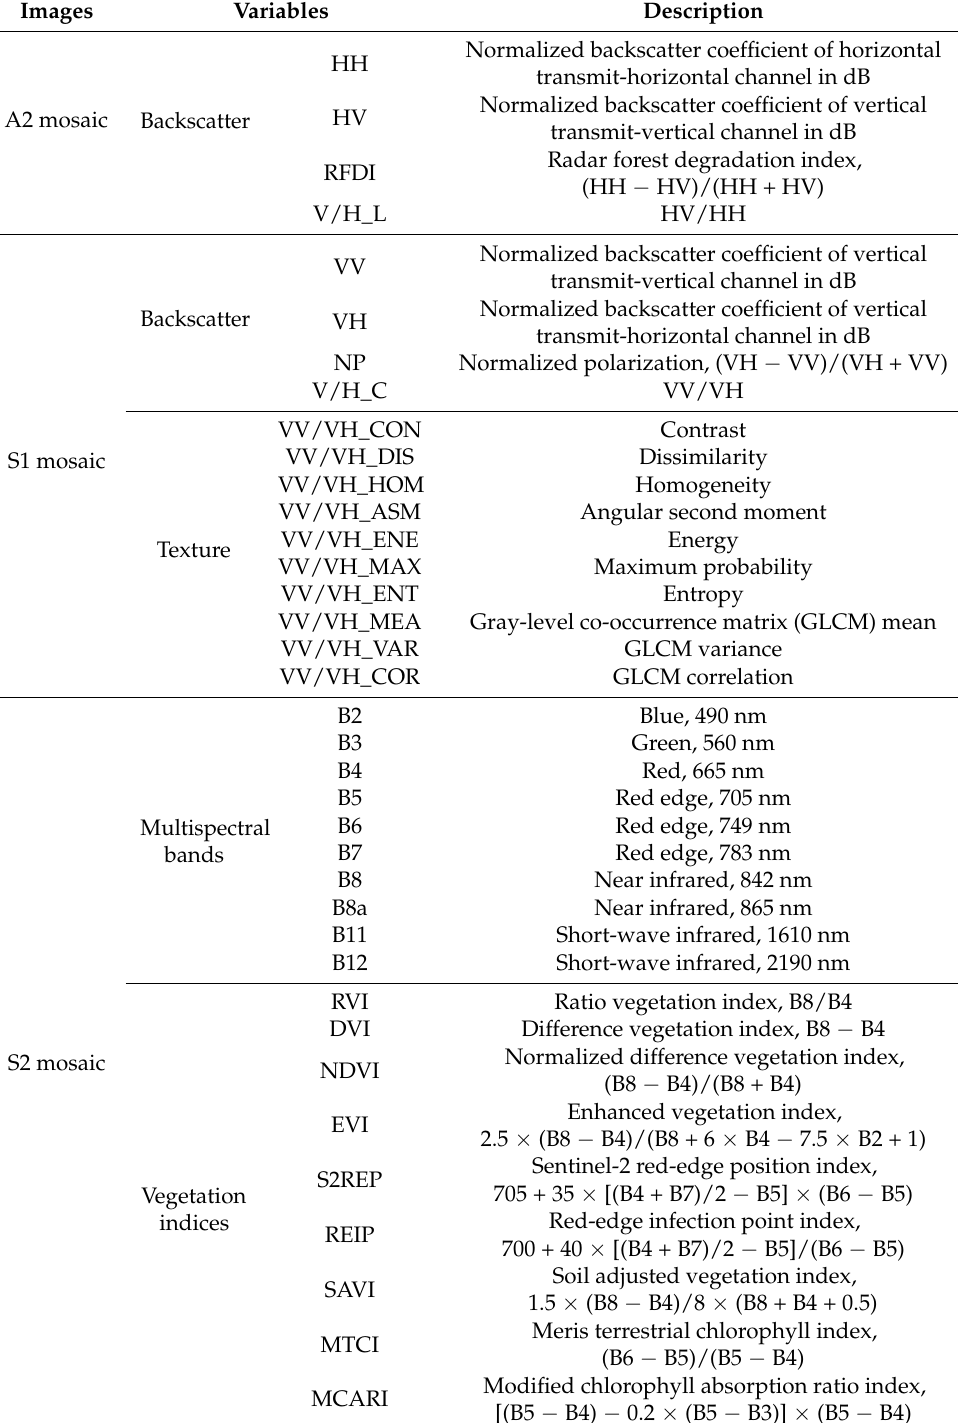
Table 4. Multi-sensor variables for AGB